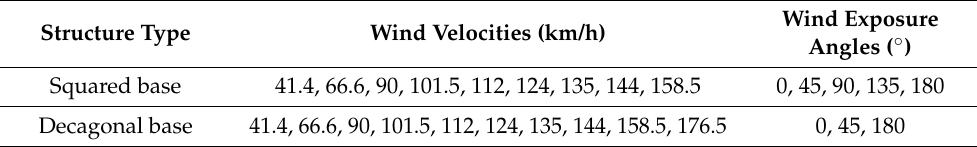
Table 2. Tests summary.